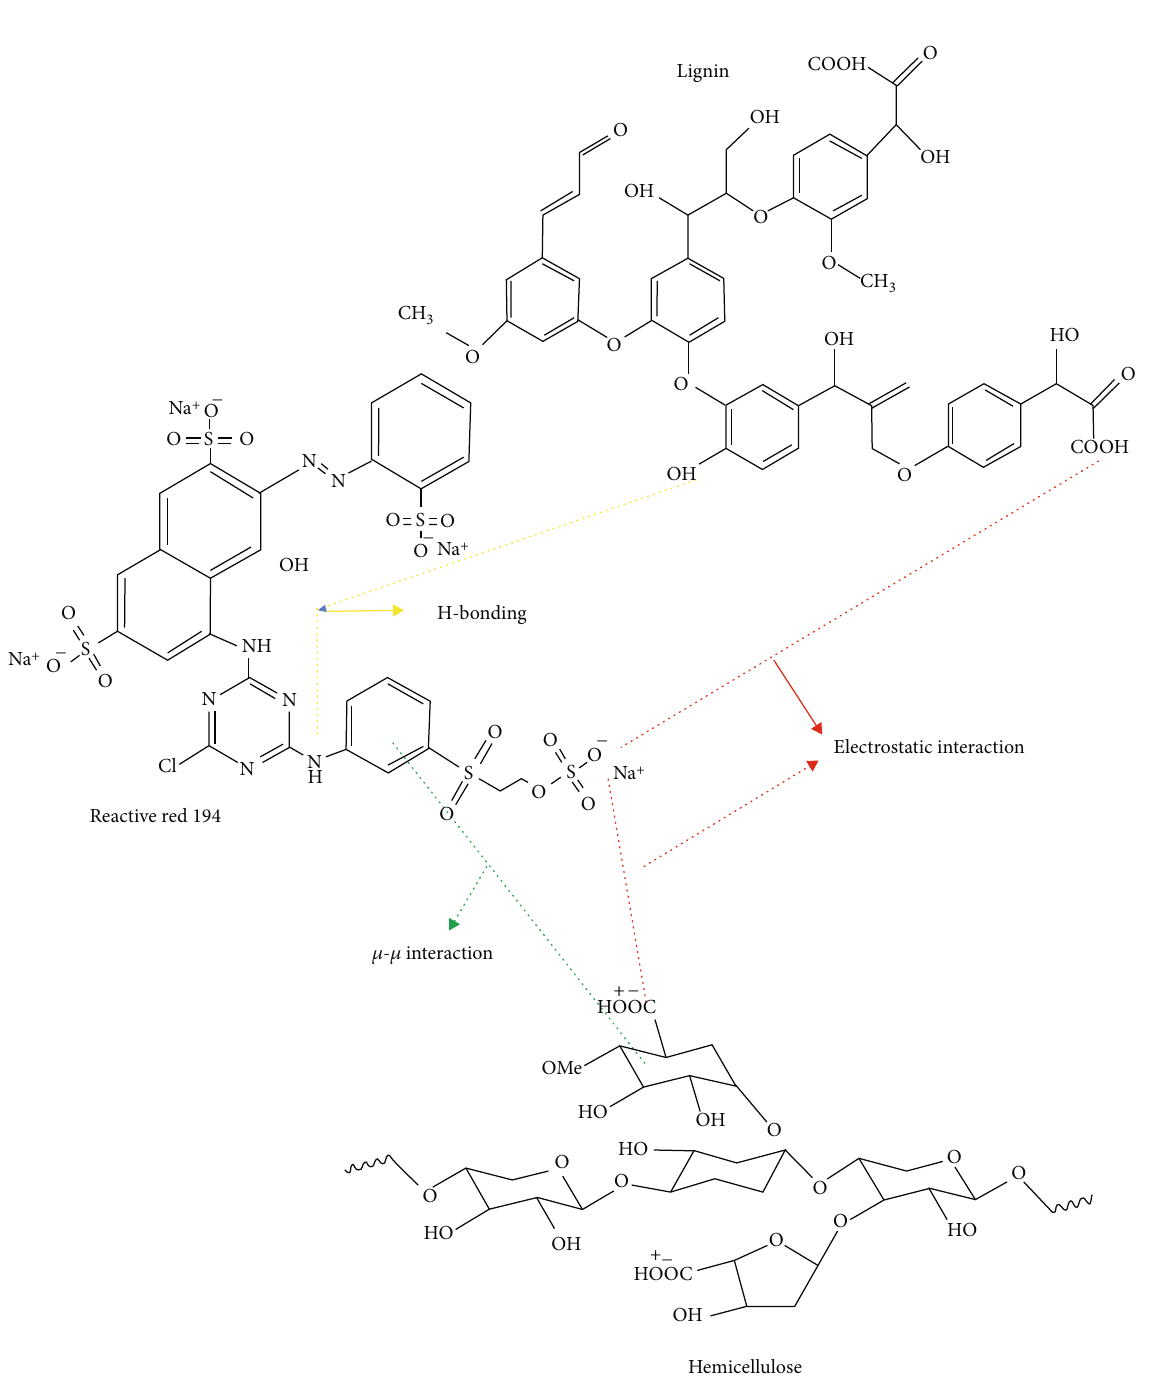
Figure 14: Illustrative representation of Red 2BN on active sites of